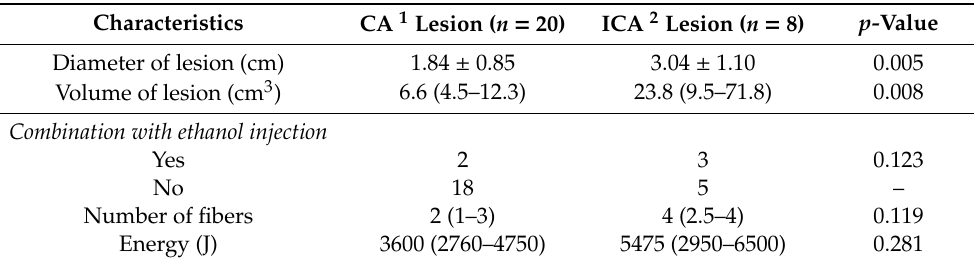
Table 3. Factors associated with ICA.